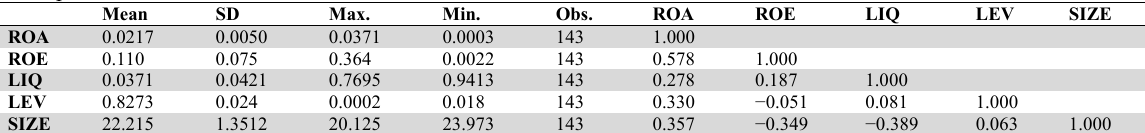
Descriptive statistics and correlation coefficients